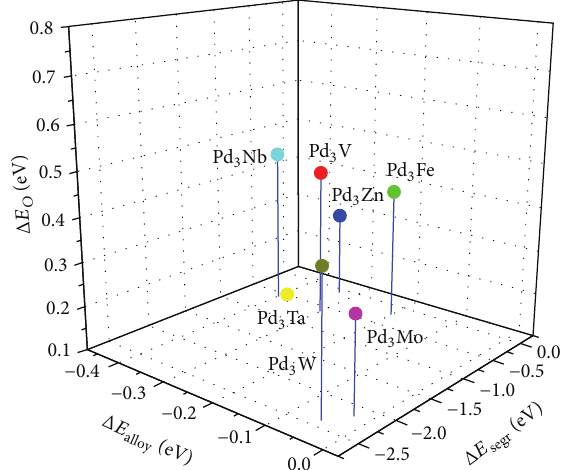
Figure 9: Three-dimensional optimization: high stability and high ORR catalytic